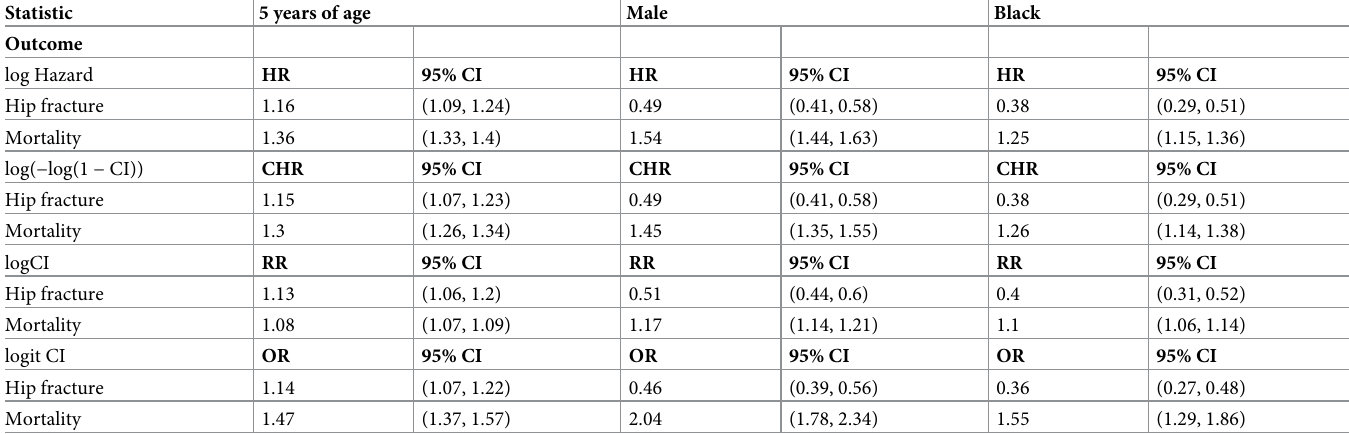
Table 4. The comparison of hazard ratios estimates, cumulative hazard ratios estimates, relative risk estimates, and odds ratios estimates for cumulative incidence for incident hip fracture and mortality in the competing risk setting under the subdistribution